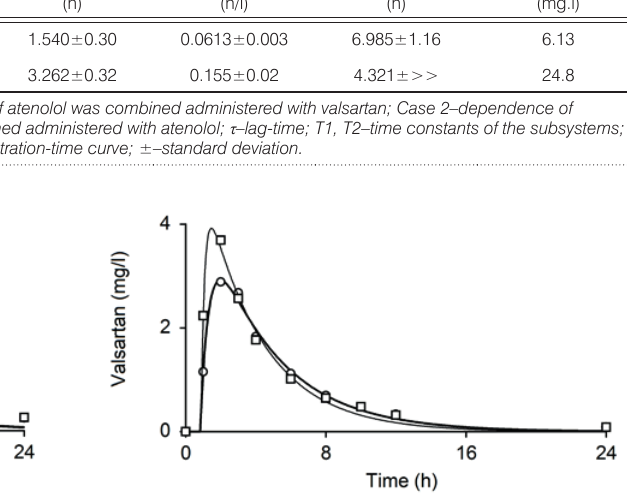
Figure 3. Concentration-time profile of valsartan administered separately and in combination with atenolol by PK model. Squares–measured concentration of valsartan adminis- tered separately; circles–measured concentration of valsar- tan administered in combination with atenolol; line–model approximation.